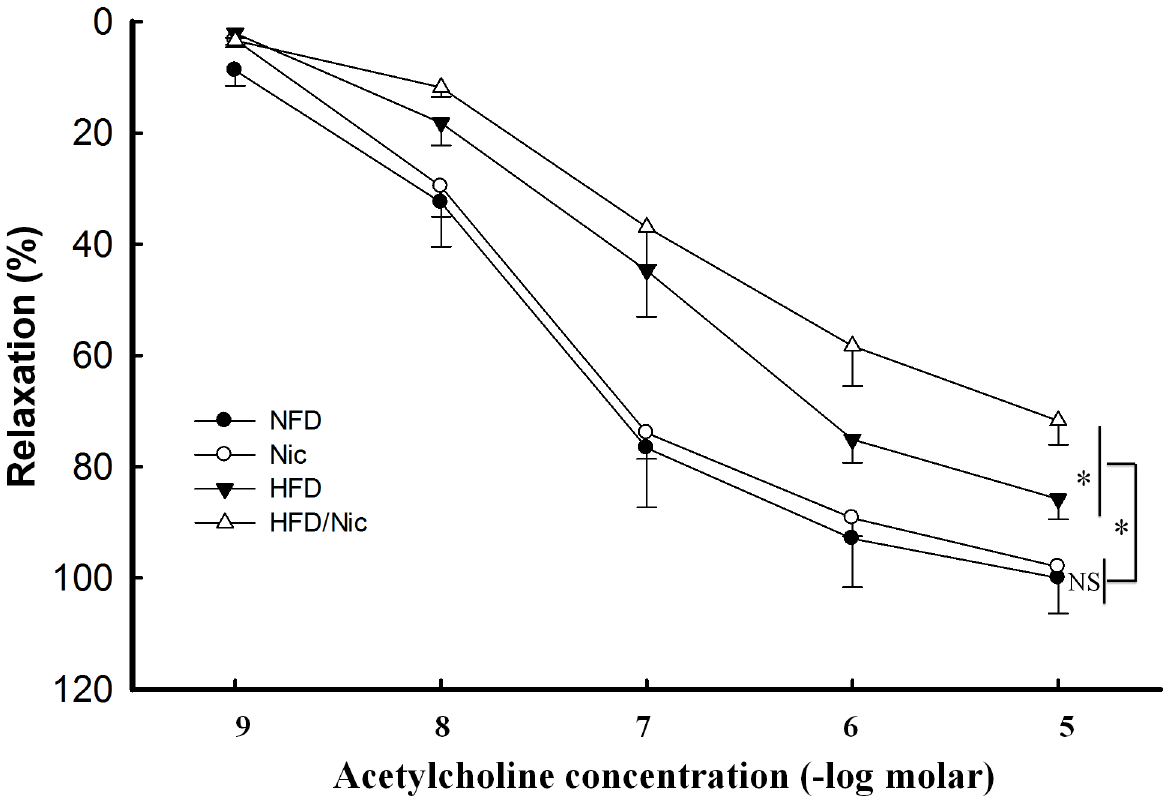
Fig 6. Endothelium-dependent relaxation (EDR) to acetylcholine in the aorta of nicotine-treated obese rats. EDR to acetylcholine was attenuated in obese rats. Nicotinefurther impairedthe EDR to acetylcholinein obese rat but not in lean rats. NS: no significantdifference. N = 5–7, * p <